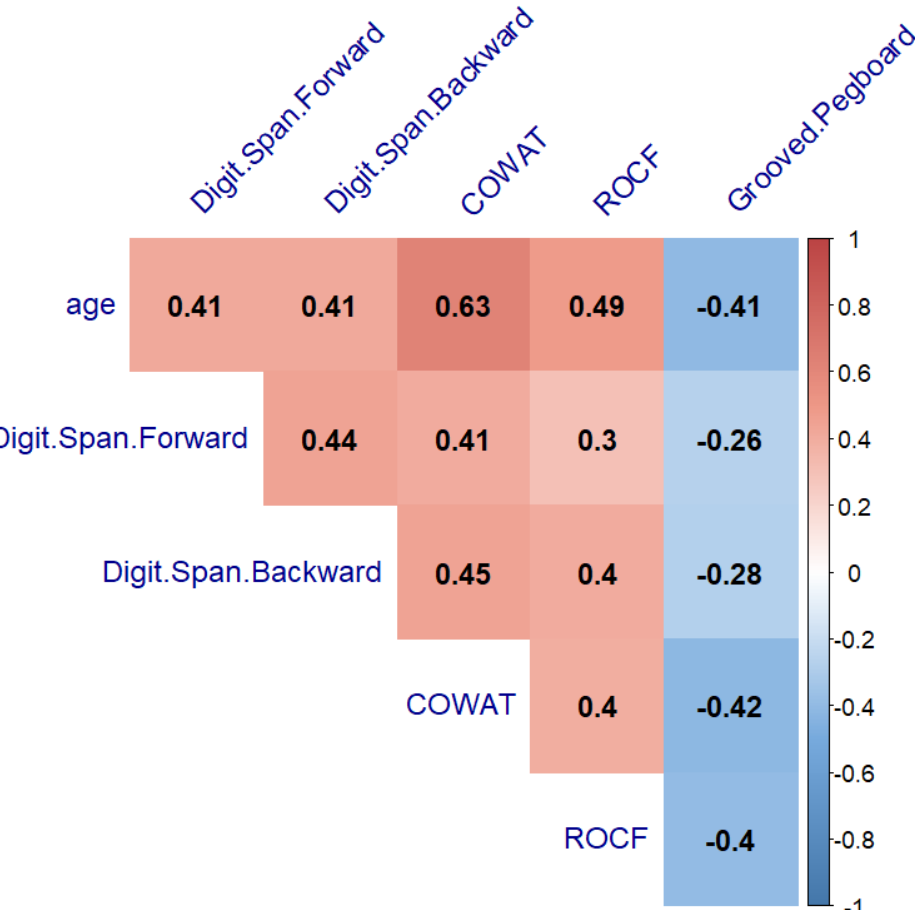
Figure 6. Heatmap of neurocognitive test results and age relationship in the healthy control group showing Spearman’s correlation after the FDR correction. COWAT—Controlled Oral Word Associa- tion Task, ROCF—the Rey–Osterrieth Complex Figure.